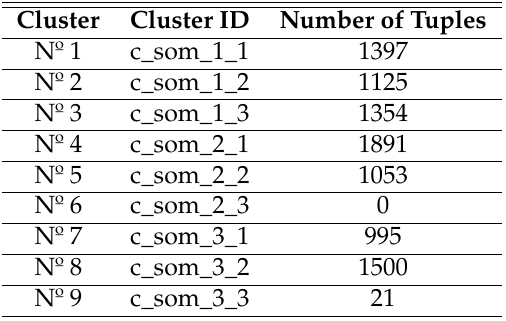
Table 1: Number of Tuples Assigned per